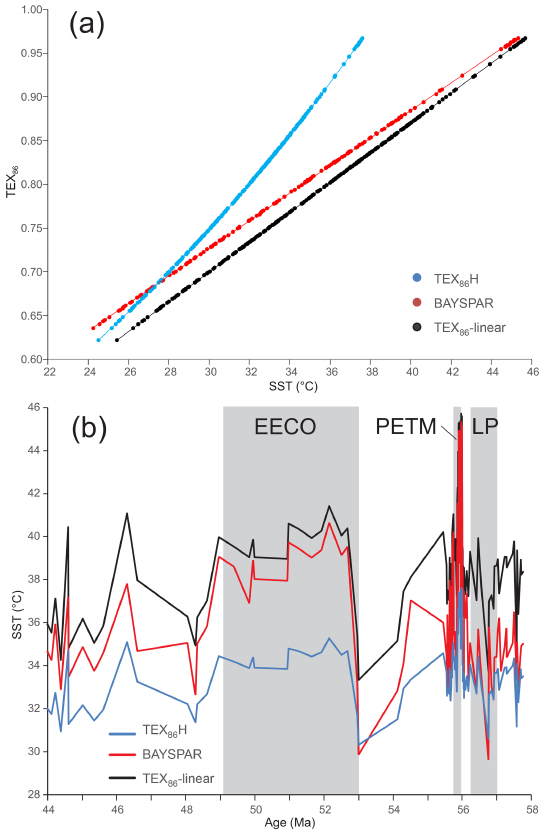
Figure 4. Relationships between TEX 86 calibrations and sea sur- face temperature for low-latitude Paleocene–Eocene sites (data from Cramwinckel et al., 2018). (a) Comparison of the exponential TEX H calibration (Kim et al., 2010), the linear TEX 86 (O’Brien 86 et al., 2017) and BAYSPAR calibrations (Tierney and Tingley, 2014, 2015). Because of the spatially varying regression used for BAYSPAR, only one site (ODP Site 959) is plotted for this calibra- tion. (b) Comparison of SST reconstructions from late Paleocene to early middle Eocene for the three calibrations. The timescale of Gradstein et al. (2012) is used in this figure. Approximate lo- cations of the three targeted time intervals are also shown: latest Paleocene (LP), Paleocene–Eocene thermal maximum (PETM) and early Eocene climatic optimum